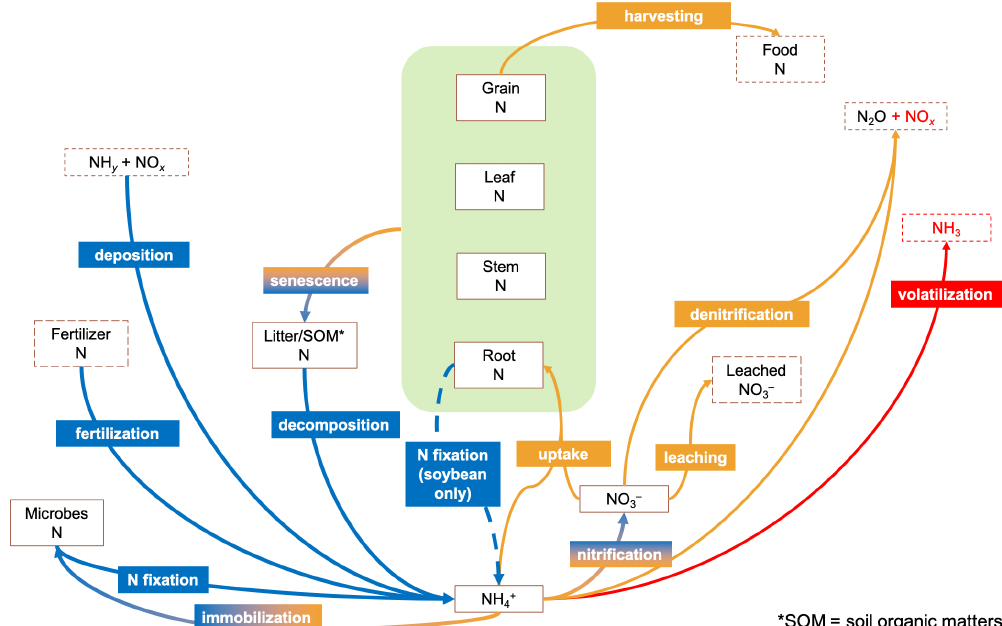
Figure 1. Major pathways modeled by CLM5 nitrogen (N) cycle. Blue arrows indicate N entering the soil N nitrogen pool, while orange arrows are for leaving. The default model tracks only N pools in boxes enclosed by solid lines but not those with dashed lines. N contents in crop tissues are modeled as pools inside the green regions. The red arrow indicates the missing pathway of NH 3 volatilization in the default model. Nitrogen gas (N 2 ) emitted by denitrification is not shown. SOM denotes soil organic matter.